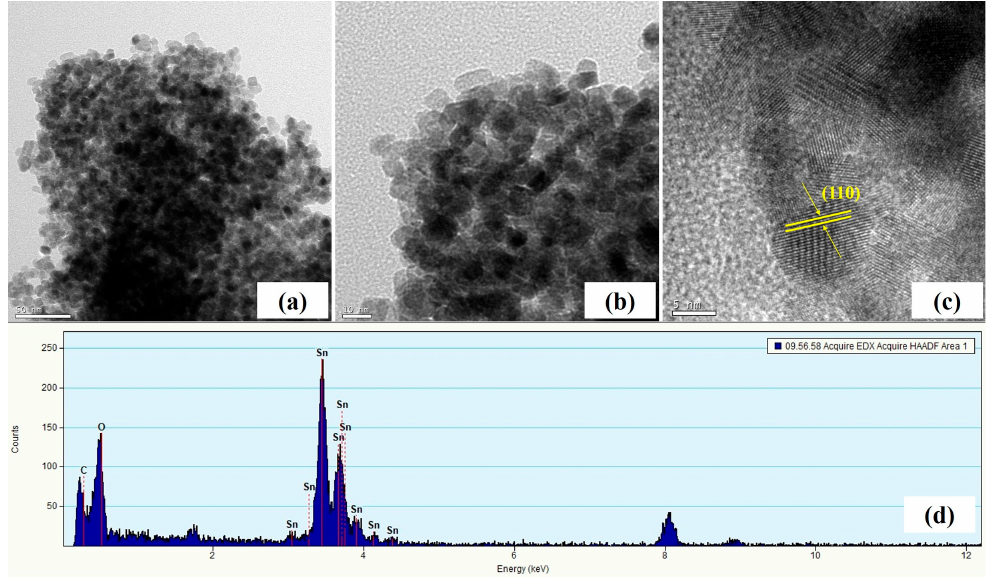
Figure 6. ( a ) Typical TEM and ( b , c ) HRTEM images, ( d ) EDX pa tt ern of SnO 2 -CNFi nanocomposite.